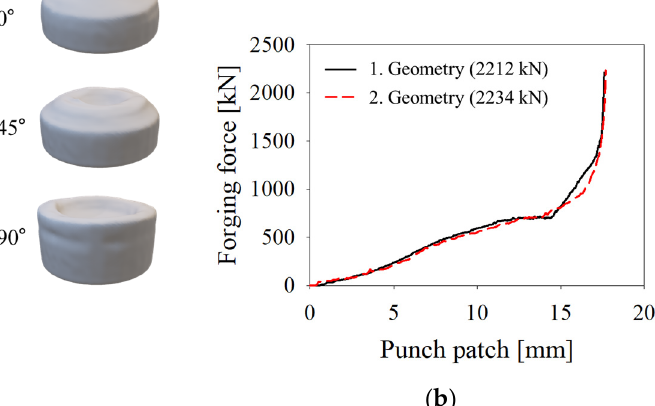
Figure 13. ( a ) Preform shapes derived by CNN#2 for a 3D model inputted at once and the case of combining the 0°, 45°, and 90° shapes and ( b ) Forging force vs. punch patch comparison for two preforms.